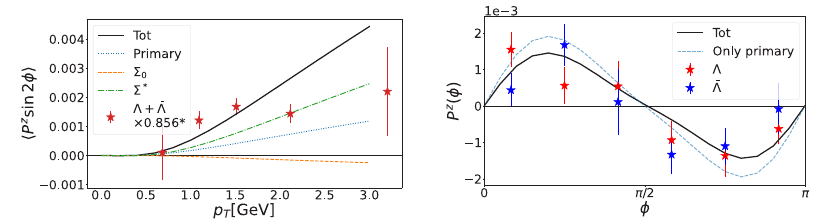
Figure 1. Calculations of the polarization vector at 200 GeV. Left panel: second Fourier harmonic of P z . The contribution of each channel is plotted after multiplication for the respective weight n ( x ) . Right panel: azimuthal dependence of the feed-down corrected P z compared to the primary-only channel. The